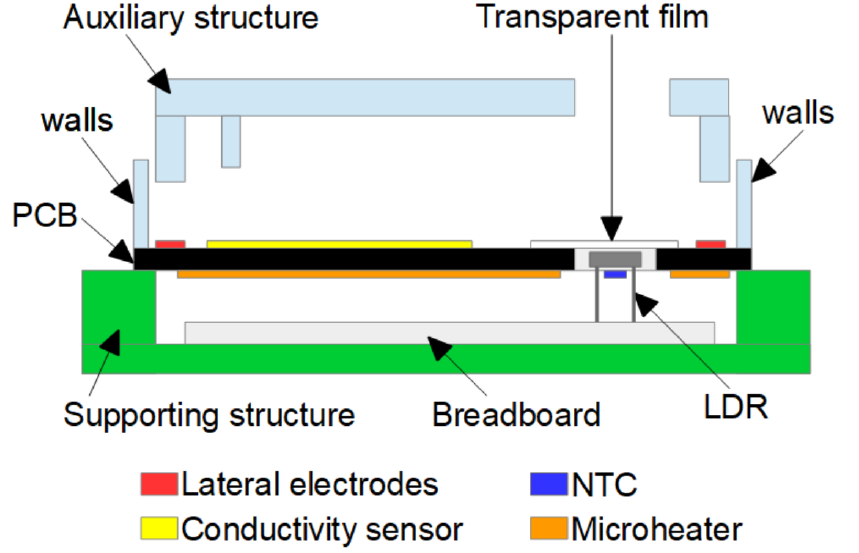
Figure 3. The cross-sectional view of the prototype is shown. The supporting structure, the bread- board and the location of the sensors and the transparent film can be seen. The negative temperature coefficient (NTC) sensor is not under the light dependent resistor (LDR), it is in a different plane. The device requires a basic signal conditioning circuit in order to manage both the cur- rent along the microheater and the measure of the sensors outputs. The whole behaviour of the lab-on-PCB for agarose gel preparation is governed by a microcontroller. The schematic of the electronic circuit can be seen in Figure